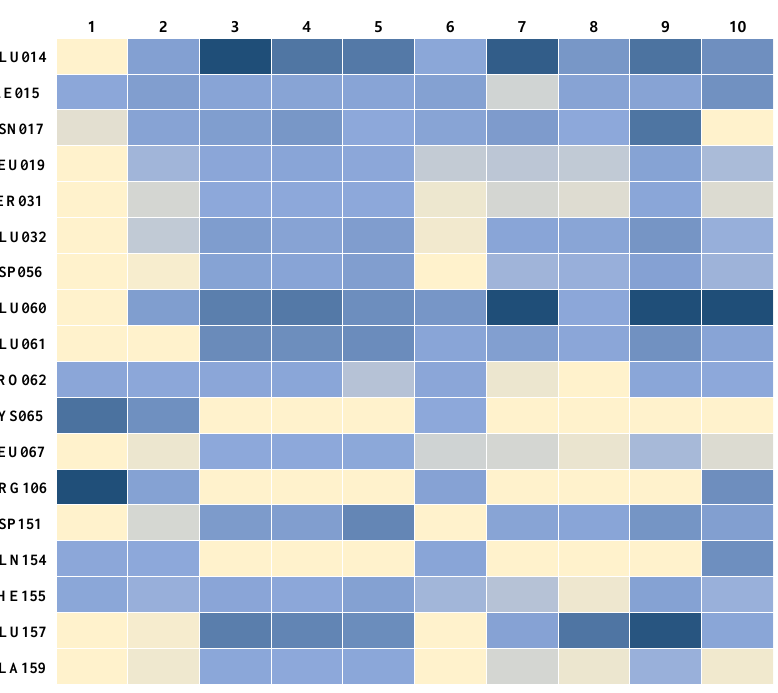
Figure 2. Comparison of hotspot residues of MMP-9 involved in ligand binding. Hotspot residues are represented in the rows. Ligands are represented in the columns. In each box of the matrix, interactions between the ligand and the residues are colored from dark blue (PIE < −100 kcal/mol) and blue (PIE < −3 kcal/mol), to light-yellow (PIE > 0 kcal/mol). The PIE values are calculated at the FMO–RIMP2/PCM level.